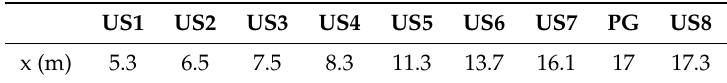
Figure 2. Schematic side view of the experimental flume including the local coordinate system—the locations of the points are given in Table 2. Table 2. Location of the measurement points of the ultrasonic sensors (US) and the point gauge (PG) shown in Figure